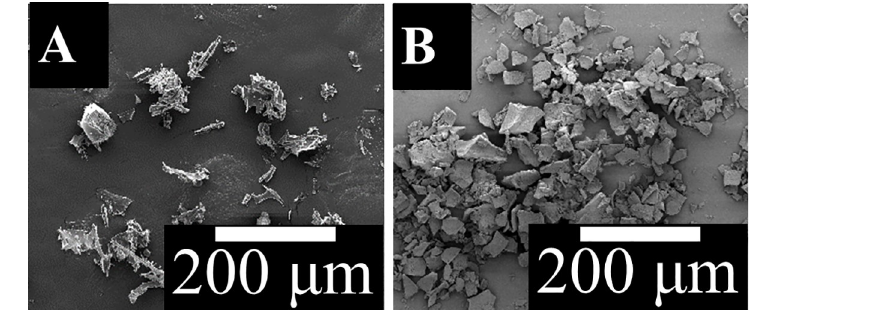
Fig 2. SEM images of A) C s and B) C p